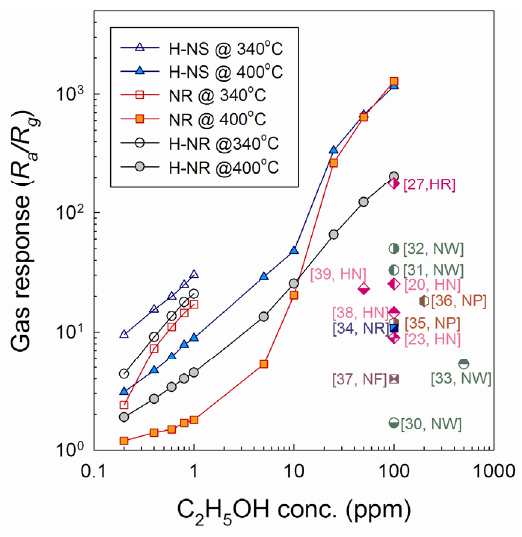
H OH of H-NS, NR, and H-NR sensors 2 5